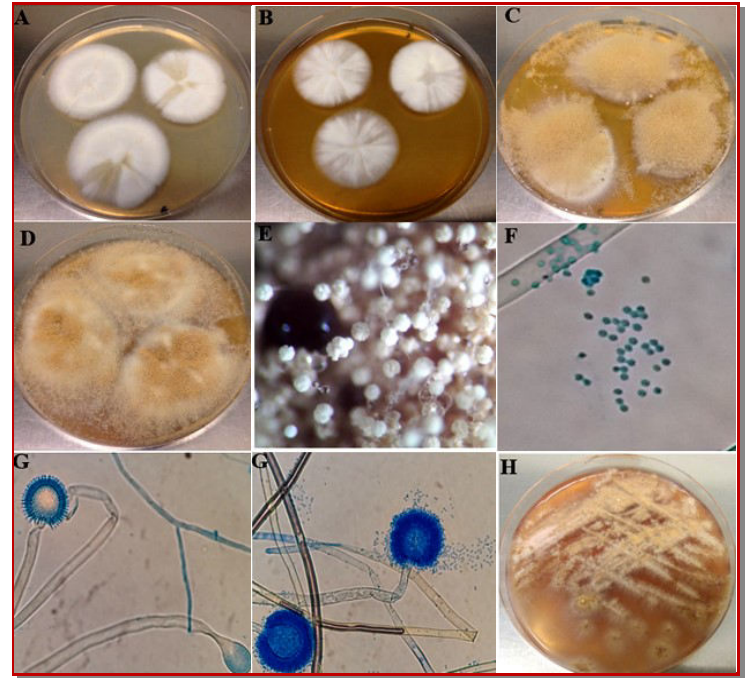
Figure 1: Morphological characteristics of PLR9 isolate: Colony surface on potato dextrose agar (A), malt extract agar (B) after 7 days, potato dextrose agar (C), malt extract agar (D) after 10 days of incubation at 28 °C. Conidiophore + exudates under zoom stereo binocular microscope (E). Conidia (F), Conidiophore, mycelium (G) under microscope, and reddish/brownish pigments production